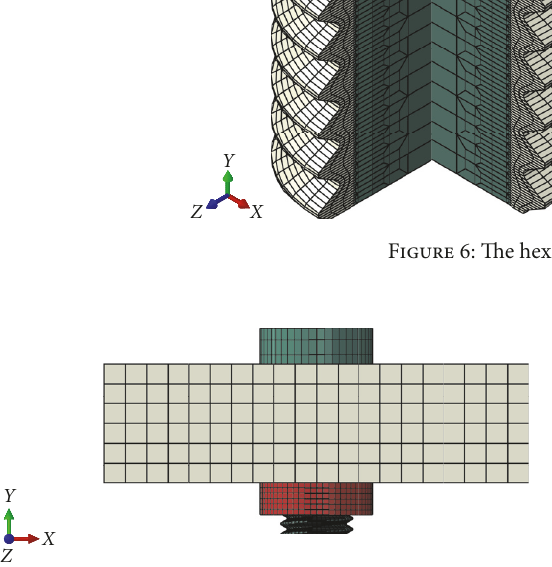
Figure 7: The whole hexahedral model of a typical bolt joint.